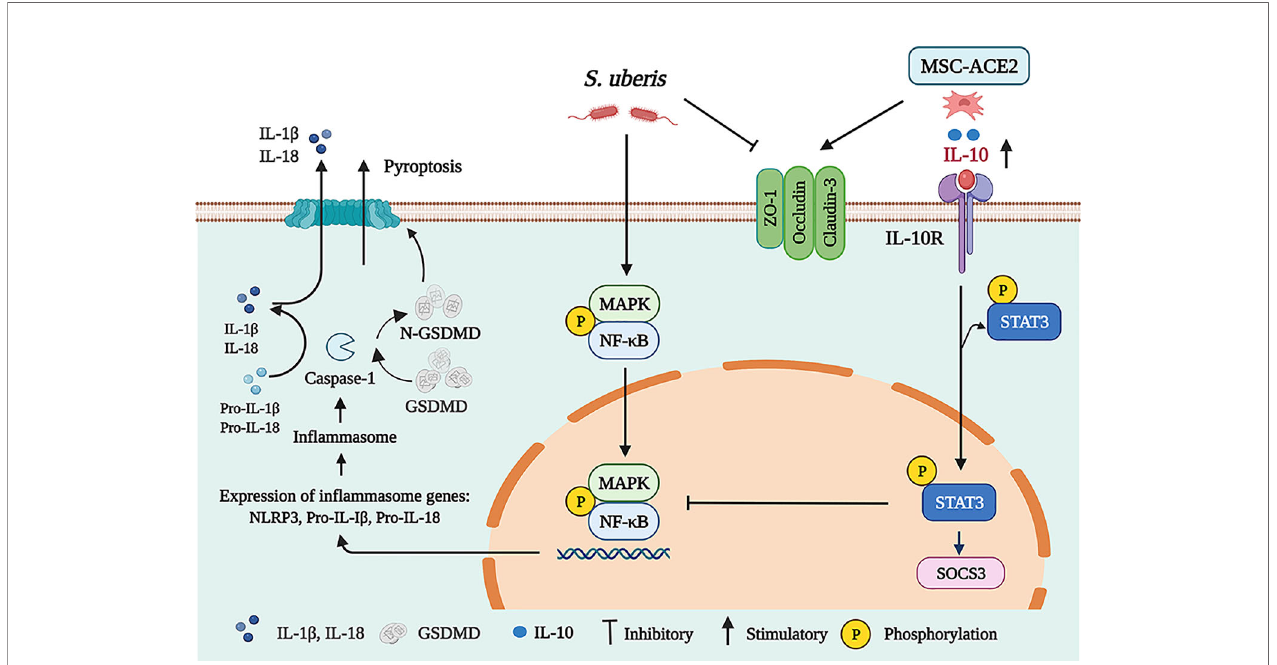
FIGURE 9 | Schematic representation of MSC-ACE2 ameliorate S. uberis -induced In fl ammatory Injury in Mammary Epithelial Cells by upregulating the IL-10/STAT3/ SOCS3 Pathway (Charting with BioRender.com software). Treatment of EpH4-Ev cells with S. uberis at MOI = 10 for 3 h caused EpH4-Ev cells pyroptosis, activated MAPKs/NF- k B signaling pathways, promoted the release of in fl ammatory factors TNF- a , IL-6, IL-I b , and IL-18, induced apoptosis, and disrupted the blood-milk barrier. Co-culture with MSC, MSC-GFP or MSC-ACE2 activated the IL-10/STAT3/SOCS3 signaling pathway and inhibited MAPKs/NF- k B, apoptosis, and pyroptosis pathways. Furthermore, MSC-ACE2 reversed the S. uberis -induced downregulation of Occludin, ZO-1, and Claudin-3 expression levels and promoted blood-milk barrier repair. MSC-ACE2 had a better effect than MSC